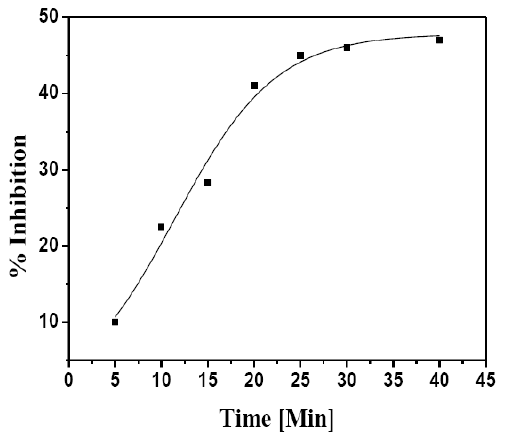
Figure 3. Inhibitory effect of different incubation time for AlOx and Hg(II) obtained at fixed concentration of AlOx (0.01U) and methanol (0.5 mM). The 0.1 mM PB, pH 7.5 was used and reaction was carried out at 35 °